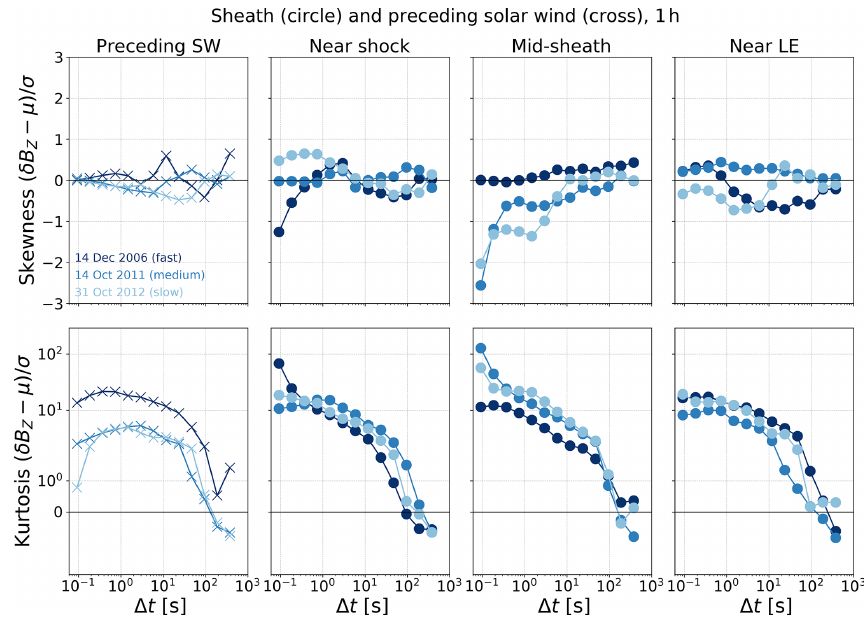
Figure 5. Skewness (top) and kurtosis (bottom) calculated for δB Z as a function of timescale (cid:49)t . Different colours and panels represent the fast (dark blue), intermediate speed (medium blue), and slow (light blue) sheaths. The dots indicate the values in the sheath, and the crosses indicate the values in the preceding solar